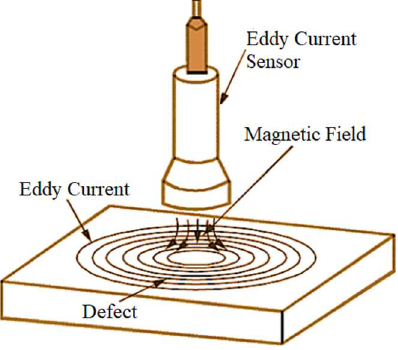
Figure 15. Eddy current system.